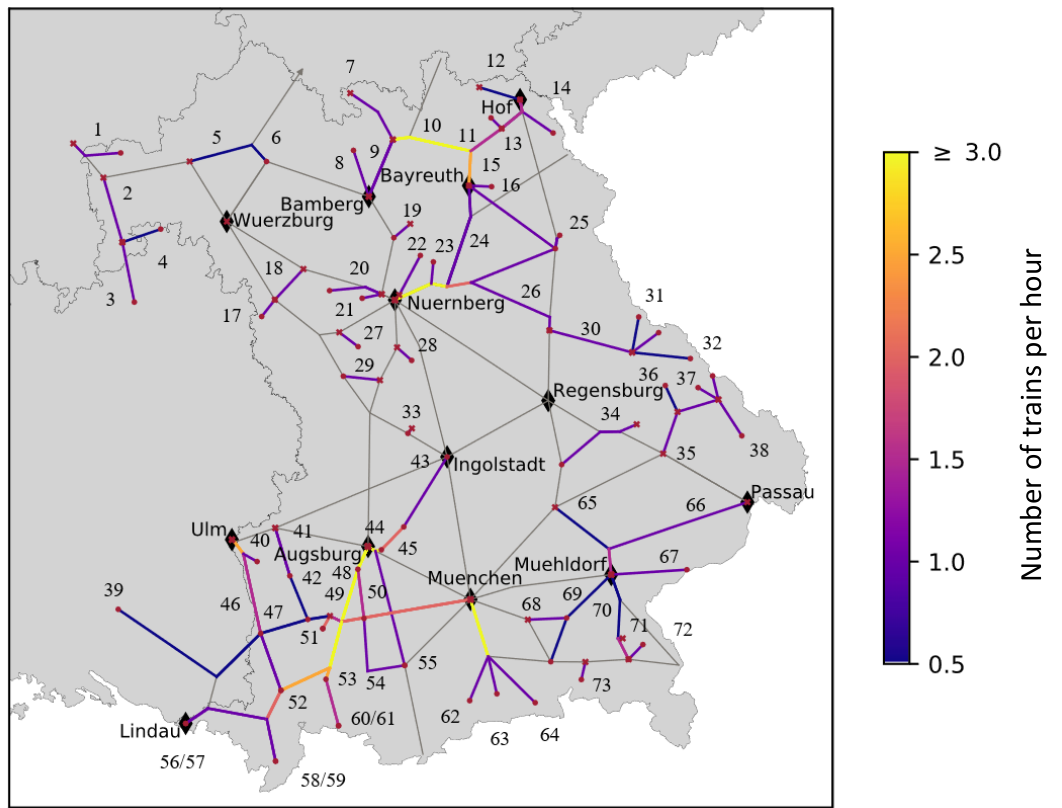
Figure C: Number of trains per hour on current diesel line